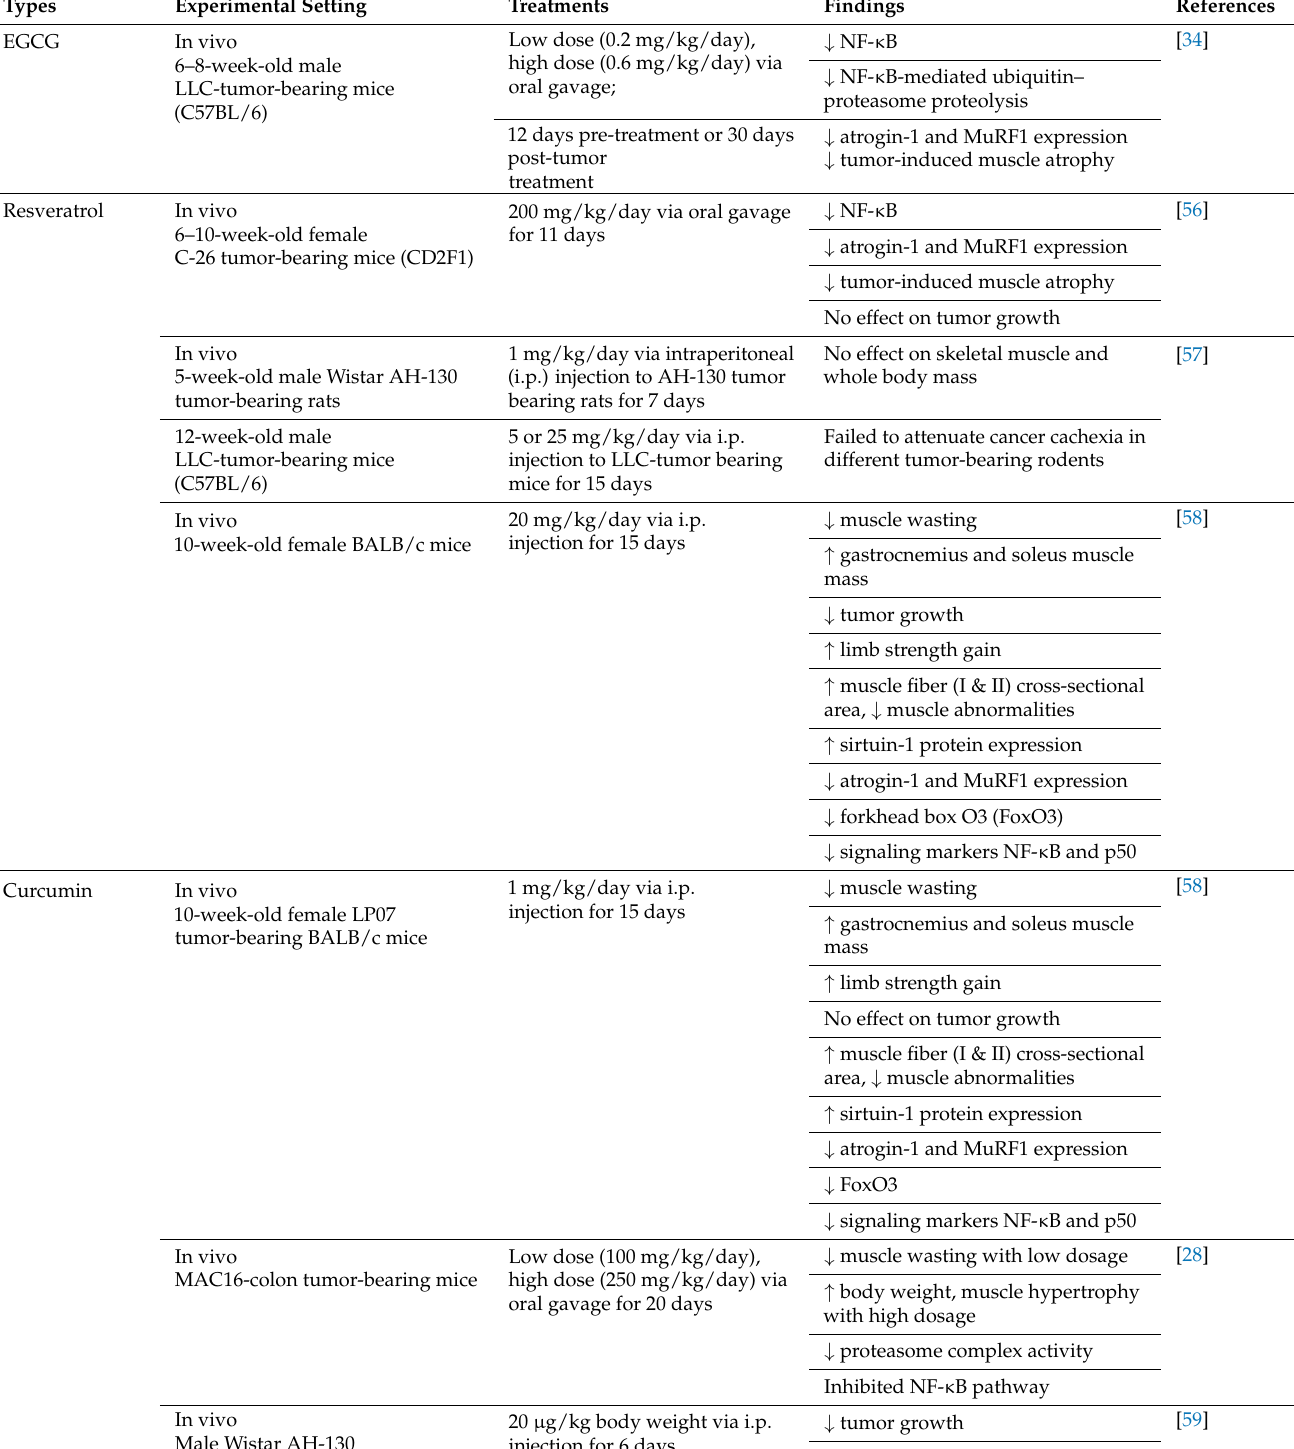
Table 1. Effect of treatment with polyphenols for cancer